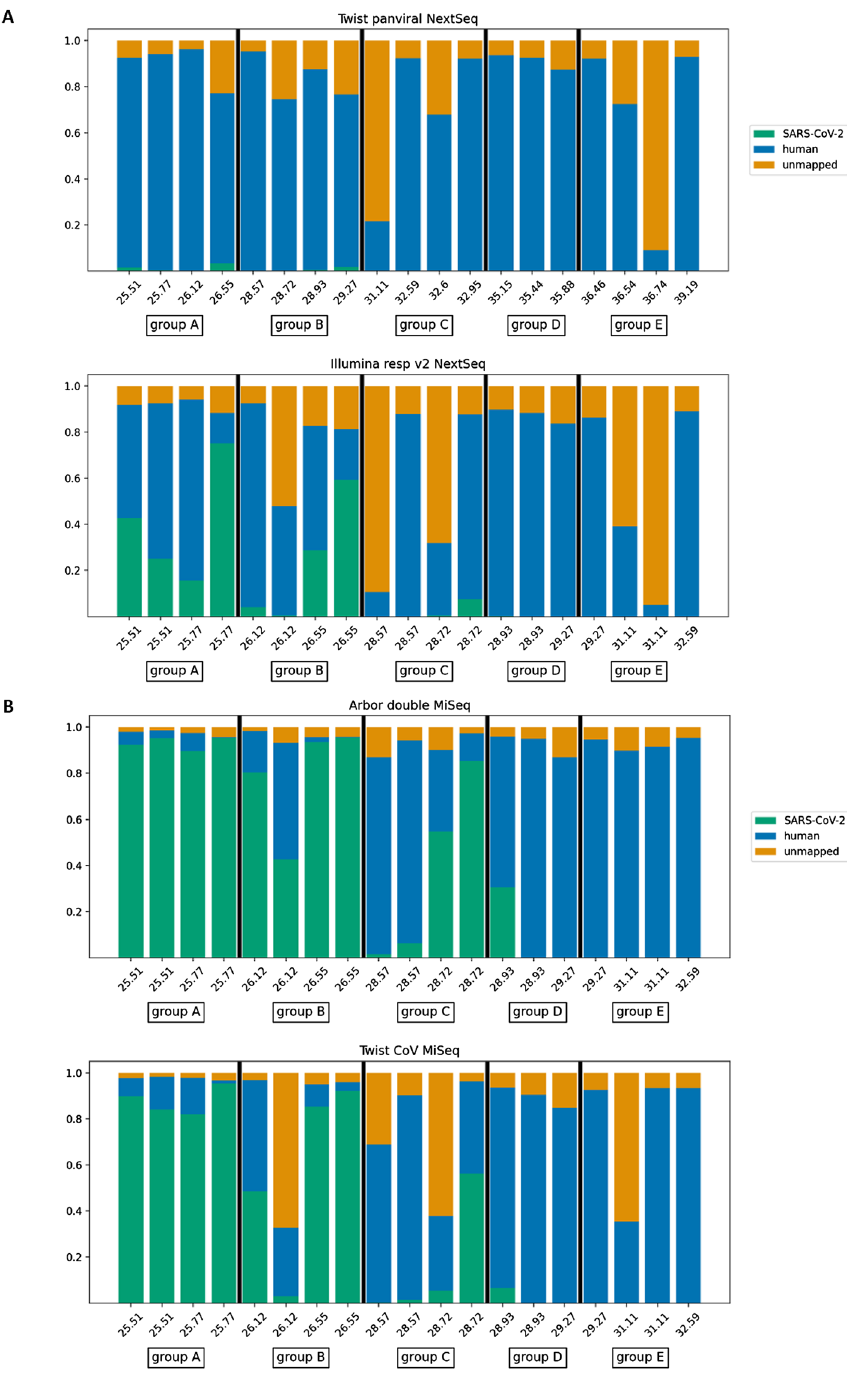
Figure 4. Fraction of reads mapped to SARS-CoV-2 or human genomes for all samples and the four panels tested. ( A ) Fraction of SARS-CoV-2 and human genomes for samples captured using the multi-virus capture panels Twist Pan-viral and Illumina Resv v2. ( B ) Fraction of SARS-CoV-2 and human genomes for samples captured using the SARS-CoV-2 capture panels from Twist and Arbor